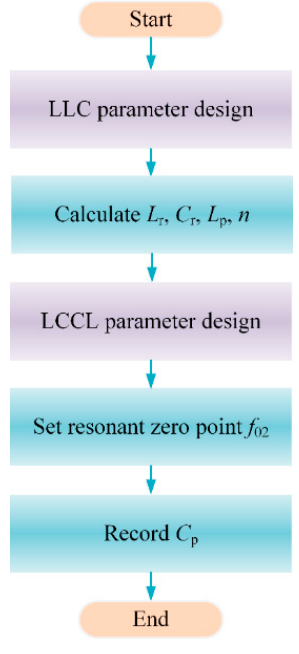
Figure 9. The parameter design process.